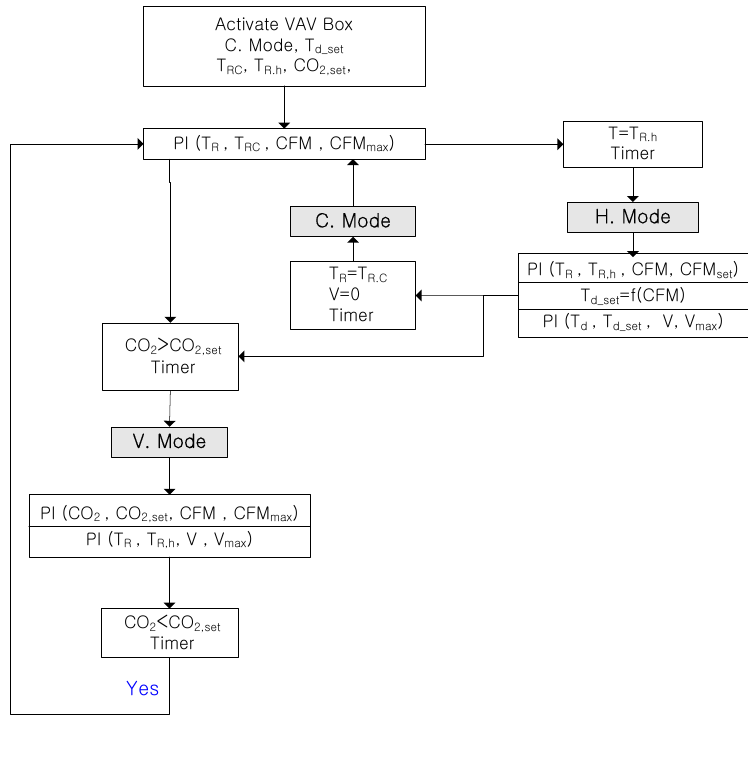
Figure 7. Flow chart of proposed control algorithms with variable minimum airflow